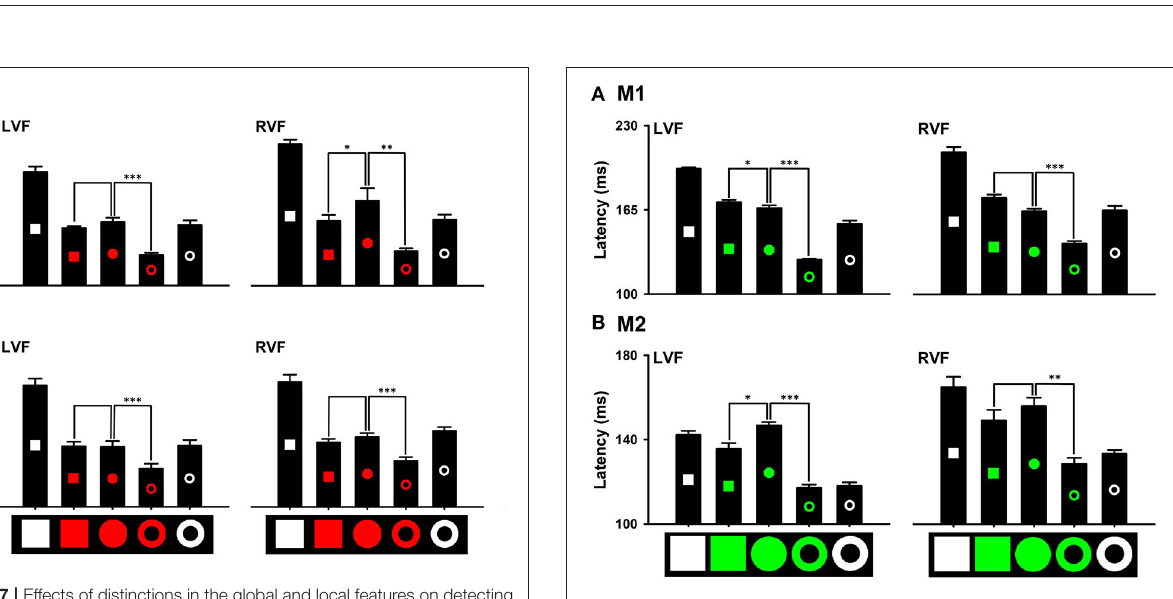
FIGURE 8 | Effects of distinctions in the global and local features on detecting the distinction in green color (A) , M1; (B) , M2. * P < 0.05; ** P < 0.01; *** P <